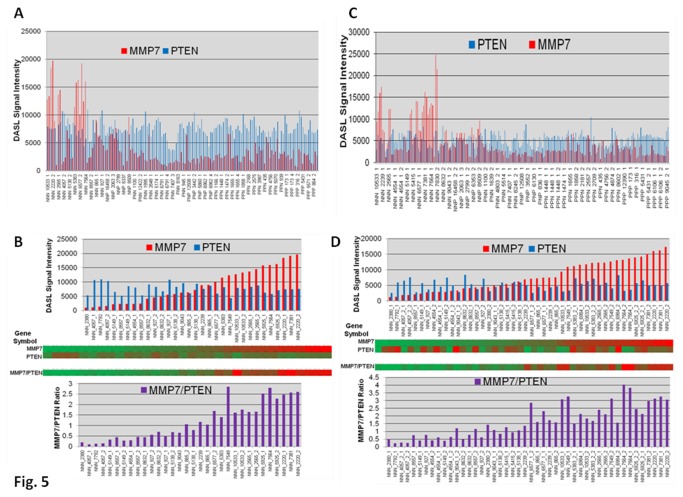
Relative levels of expression of MMP7 and PTEN mRNAs from tumors of Montreal cohort.Relative levels of expression of MMP7 and PTEN mRNAs (DASL intensities) using standard (A, B) as well as custom (C, D) panels from tumors of the Montreal cohort Data show (A & C) a differential expression of high MMP7 in the TN (NNN) tumors as compared to HR+(PPP, PPN, PNN) and HER2-enriched (NNP, PNP) groups. Analyses of levels of expression of MMP7 to the PTEN mRNAs (DASL intensities) in TN samples show that (1) MMP7 mRNA is expressed in only a subset of TN tumors (A & C), and (2) the presence of a higher level of MMP7 within the individual tumors of TN subset are associated with relatively lower levels of PTEN mRNA (B & D). These reciprocal levels of expression of MMP7 to the PTEN mRNAs (DASL intensities) were observed from the MMP7 to PTEN ratios, and heat maps of expressions in both standard (B) as well as custom (D) panels of the Montreal cohort.